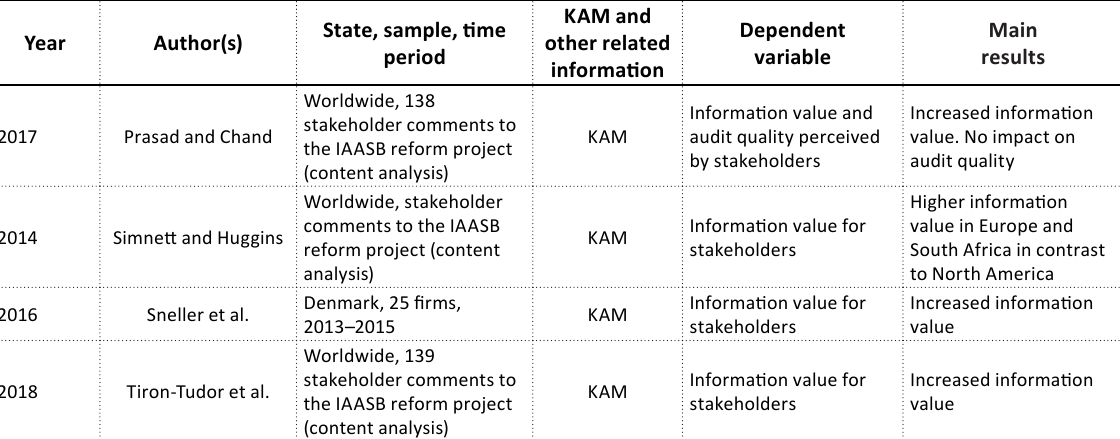
Table 7. Overview of empirical research regarding the impact of KAM and other related information on other